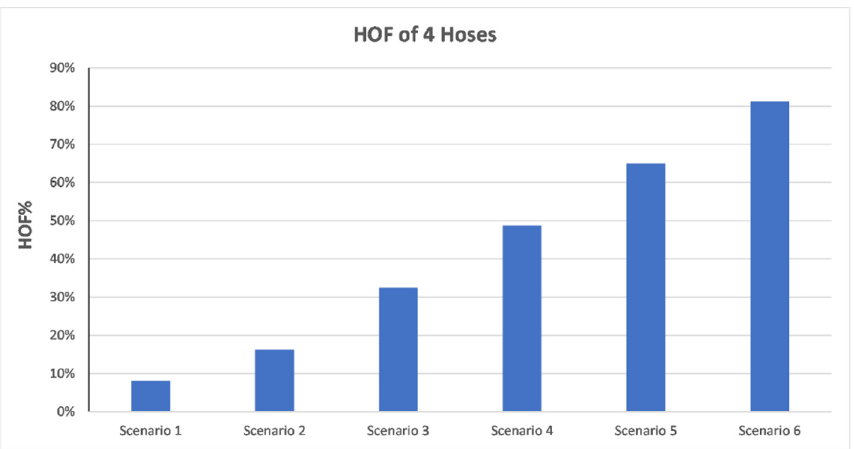
Figure 8. HOF indicator for 2 dispensers.